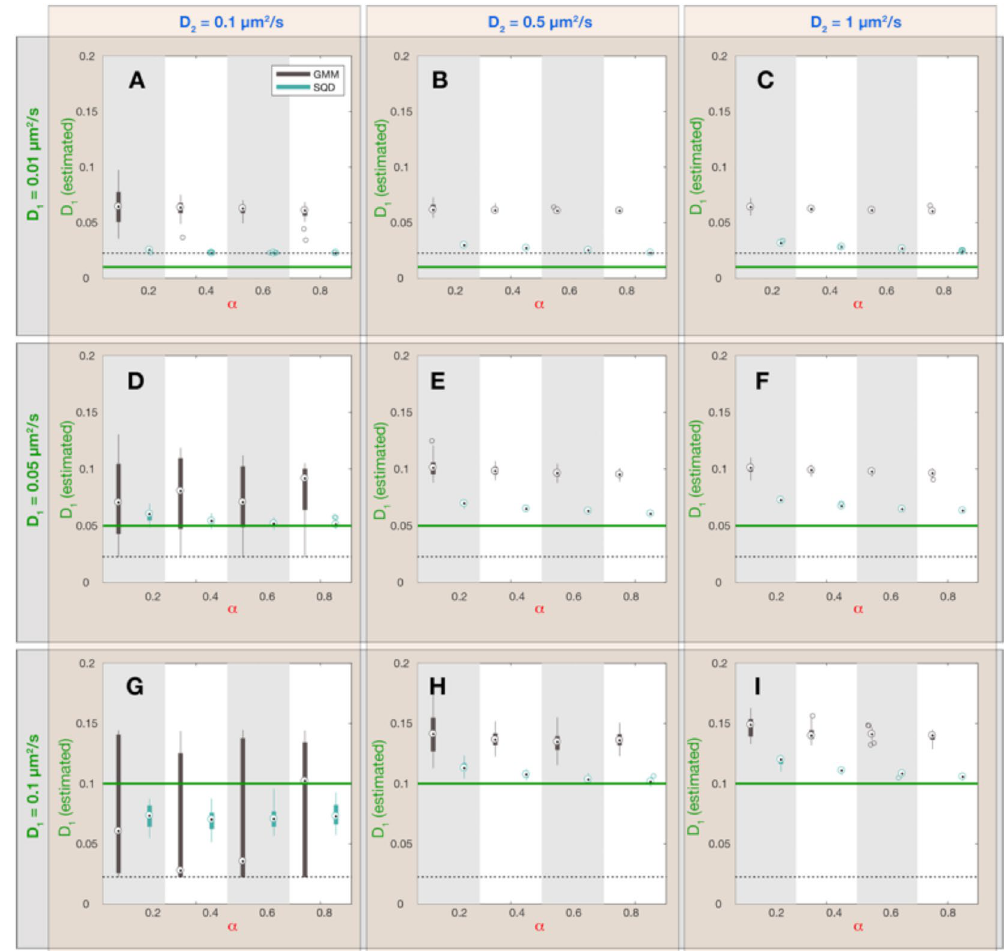
Figure 2. Dependence of estimated diffusion constant D (slow subpopulation) on simulation parameters and 1 inference method. Each panel (A–I) corresponds to a combination of simulation parameters D and D , as 1 2 indicated by the green and blue labels outside the plot panels, respectively. Within each panel 4 values of the fraction sizes α were chosen and synthetic simulations were performed on all parameter combinations. For each parameter combination ( D , D and α ) 30 simulations with 2000 tracks of 20 frames duration (see Table 1 for all 1 2 simulation parameters) were executed and the resulting data was analyzed with the GMM and SQD method, yielding two different estimates for the value of D (GMM: black boxplots; SQD: cyan boxplots). On each box, 1 the central mark is the median, the edges of the box are the 25 th and 75 th percentiles, the whiskers extend to the most extreme data points not considered outliers and the outliers are plotted as individual circles. The green horizontal lines indicate the true value for D in the simulation. The black dashed lines indicate the lower limit 1 = =